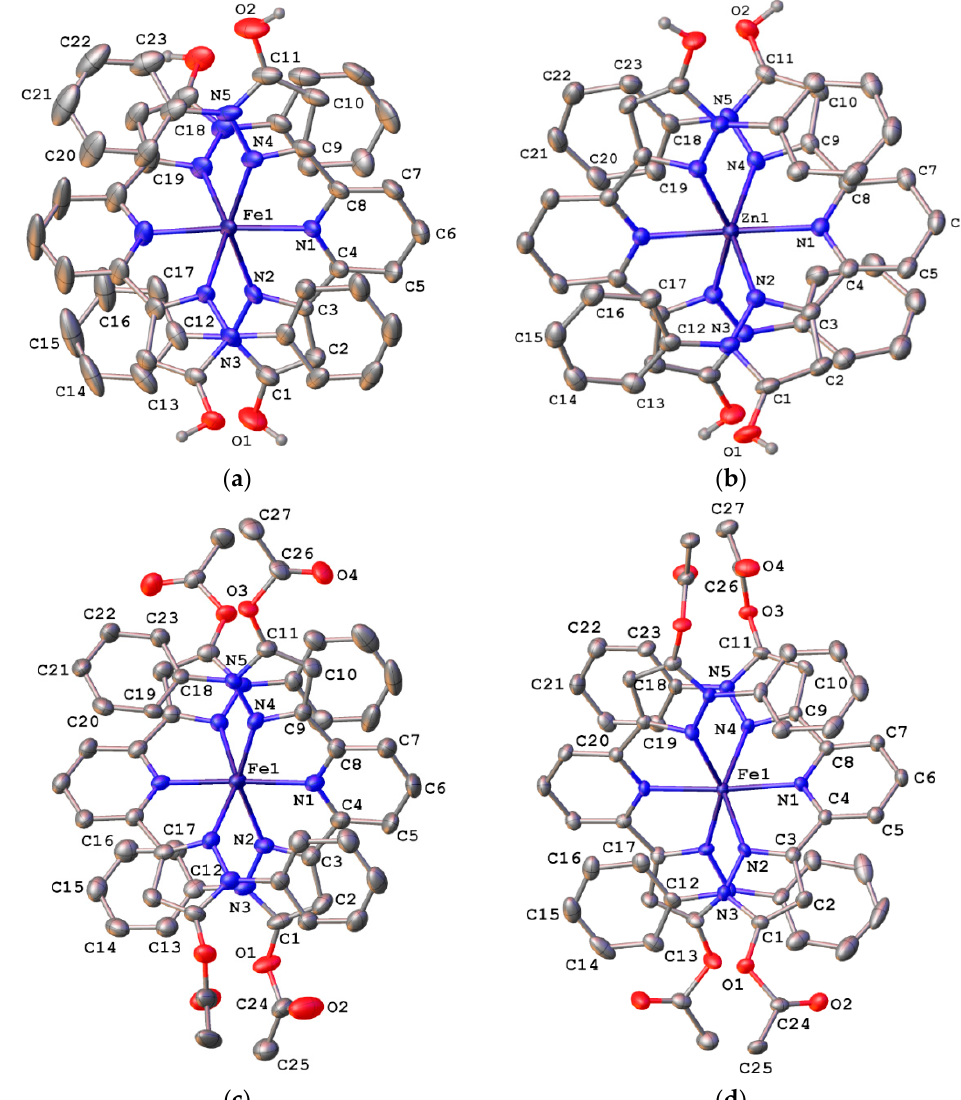
Figure 4. General view of the [ML 2 ] 2+ cations in Fe( L1 ) 2 OTf 2 ( a ), Zn( L1 ) 2 (ClO 4 ) 2 ( b ), Fe( L2 ) 2 OTf 2 ( c ) and Fe( L2 ) 2 (BF 4 ) 2 ( d ), with atoms shown as thermal ellipsoids ( p = 30%). Hydrogen atoms, except those of the hydroxy groups in Fe( L1 ) 2 OTf 2 and Zn( L1 ) 2 (ClO 4 ) 2 , are omitted for clarity.